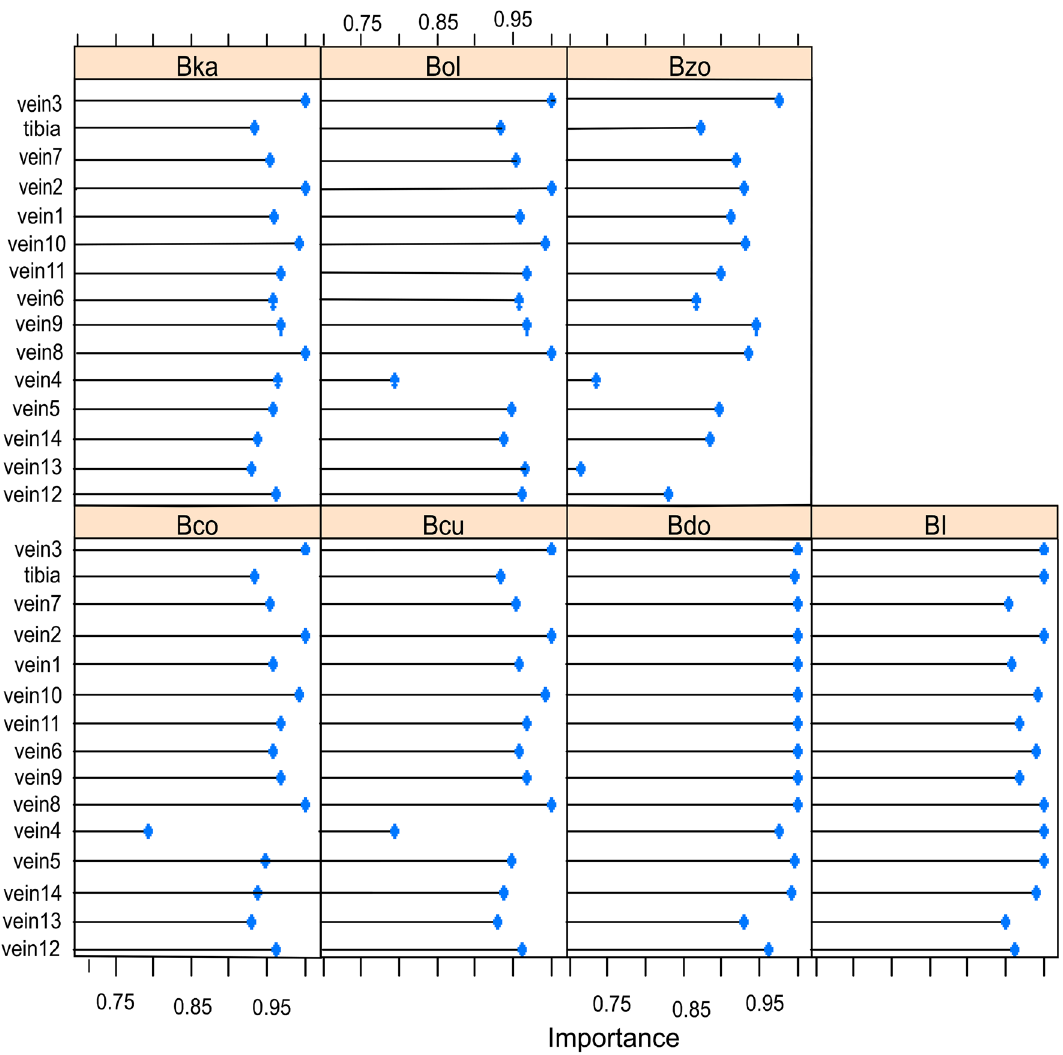
Figure 3. Analysis of variable importance (VI) for the radial kernel SVM model. Veins 3, 2, 8, and 10 are identified as predictors of higher importance than others in all species except for Bdo ( B. dorsalis ) and BI ( B. invadens